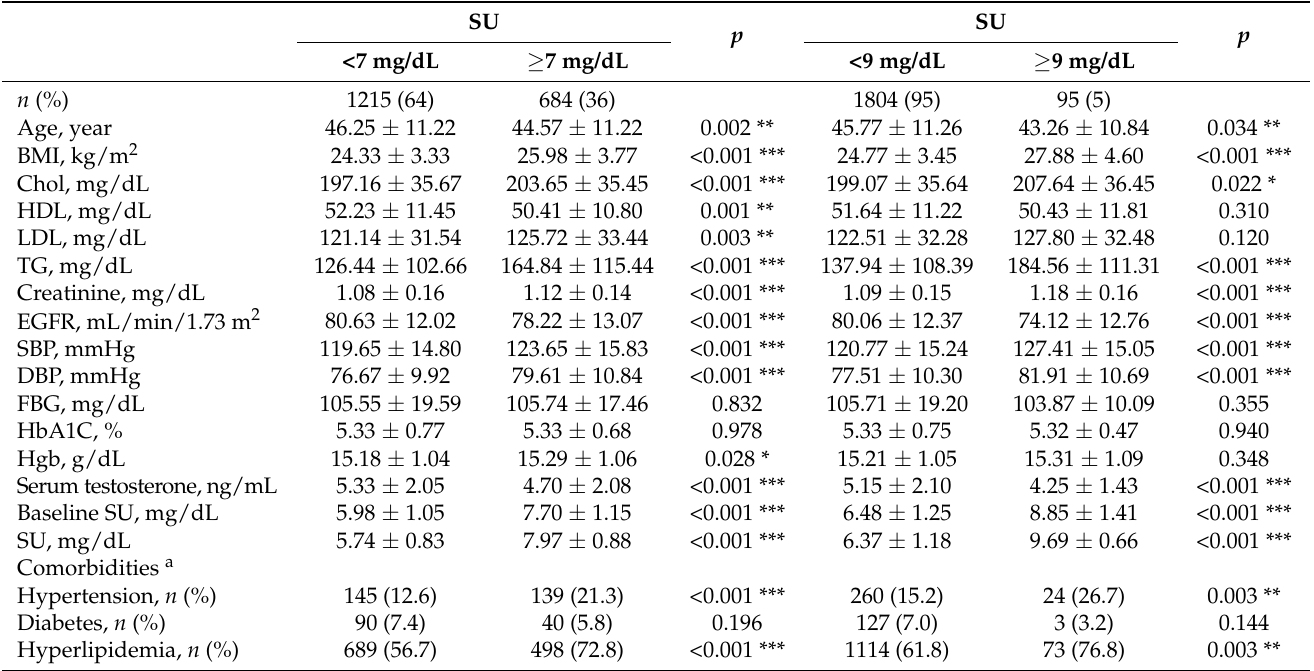
Table 1. Baseline participant characteristics according to their serum urate